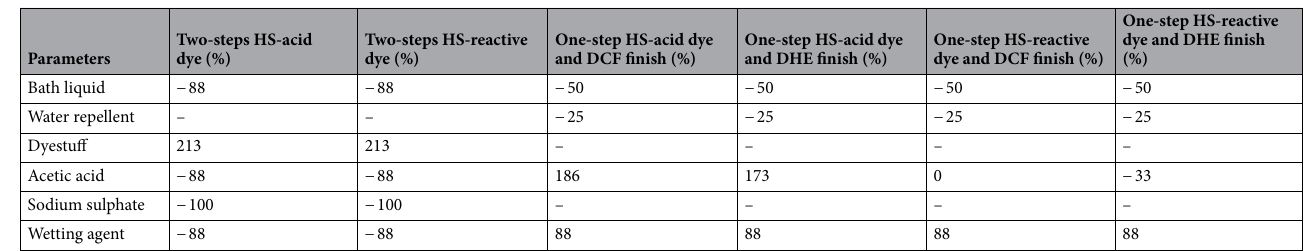
Table 5. Sustainable aspect of HS methods compared to conventional